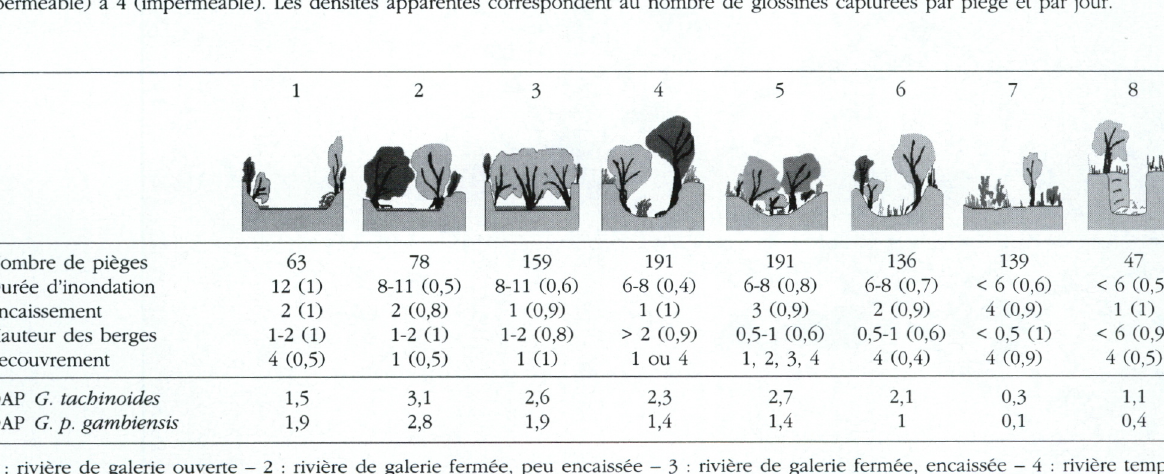
Fig. 14. - Architectures de cours d’eau, principales modalités et densités apparentes correspondantes. Entre parenthèse sont indiqués les fréquences des modalités. Les durées d’inondations sont en mois. L’encaissement est noté de 1 (très encaissé) à 4 (horizontal). Le